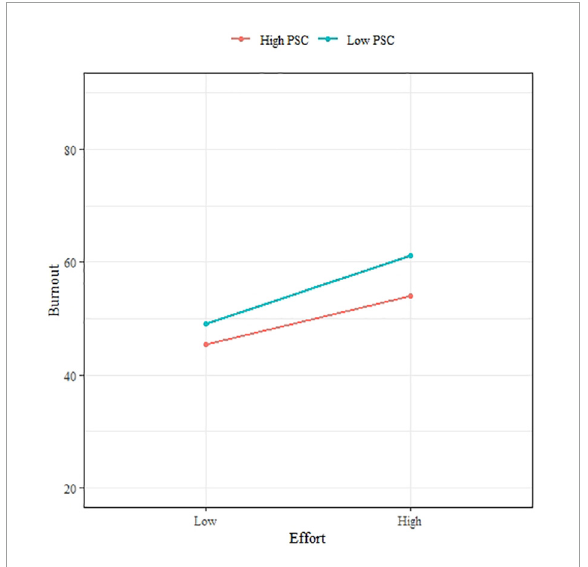
FIGURE3 The interaction between effort and PSC on burnout.